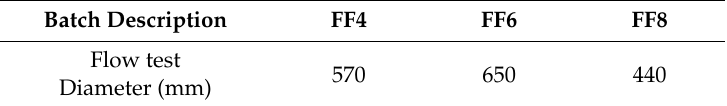
Table 3. Slump-flow test results.